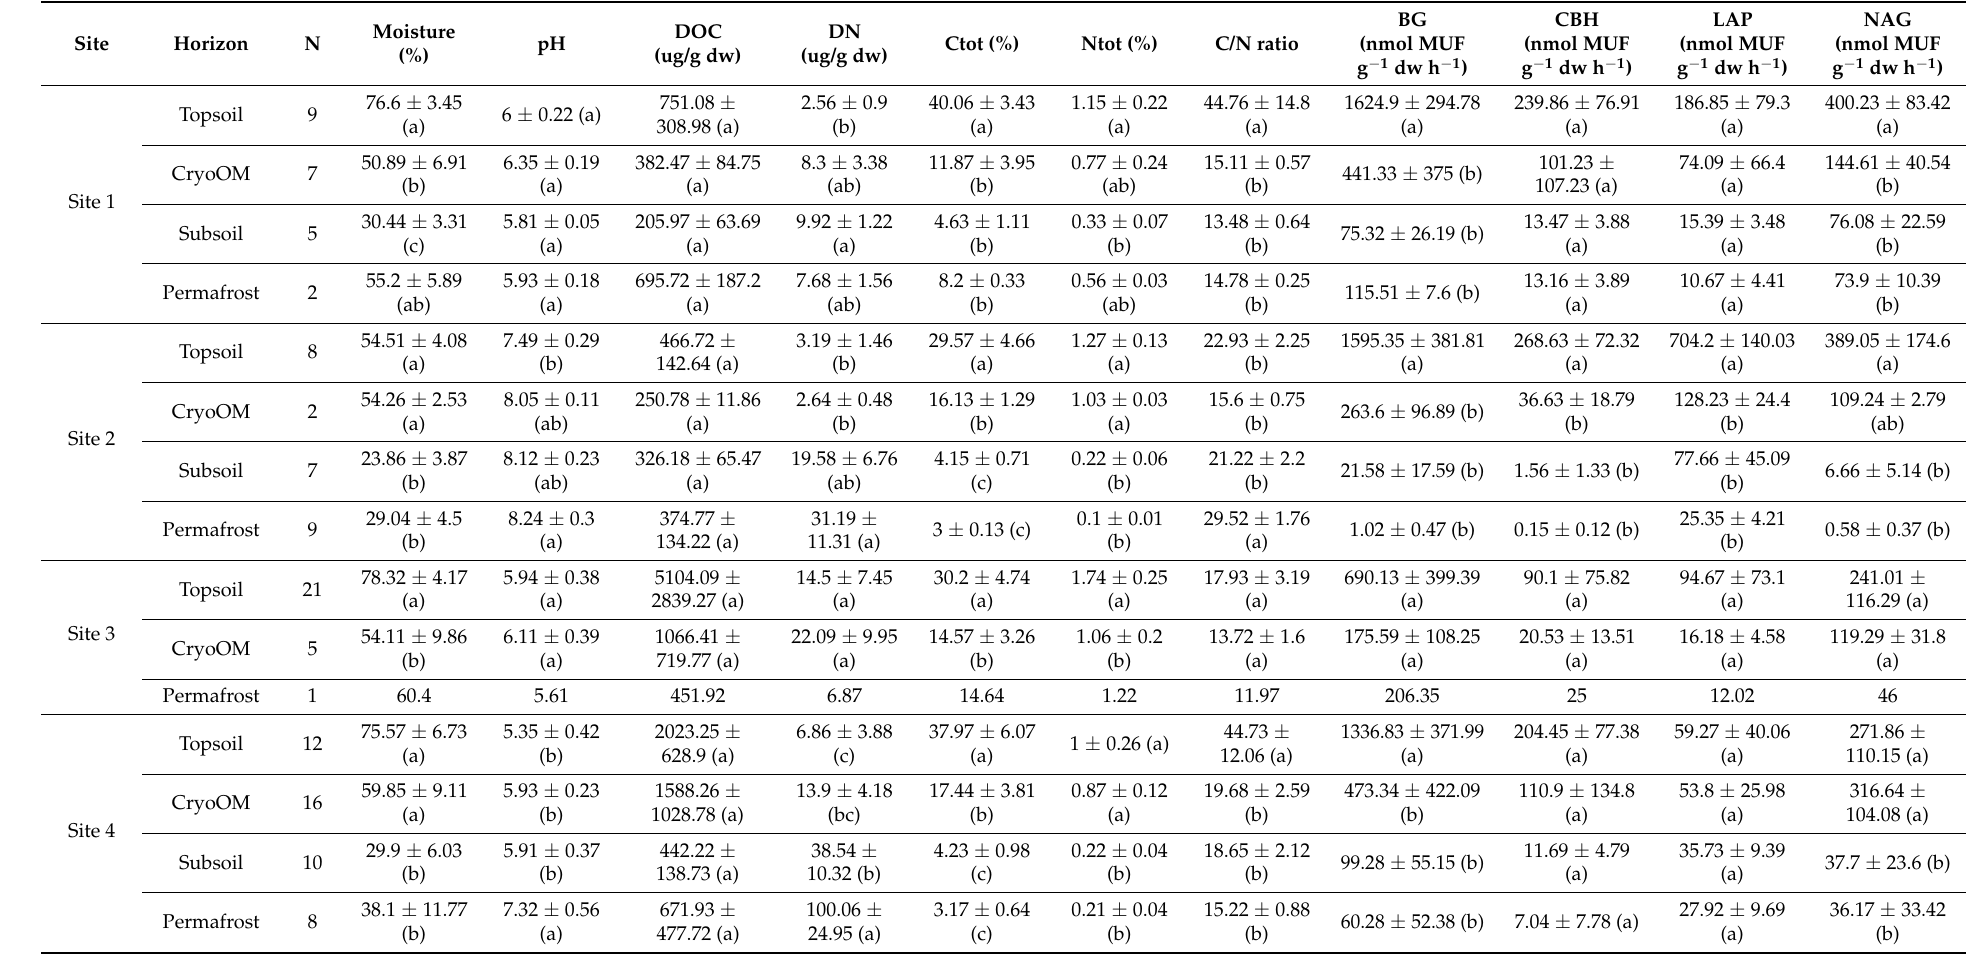
Table 1. Soil environmental factors in each horizon. Averages and standard deviation were shown. The significant difference between different horizons within all tundra sites were calculated using One-Way ANOVA and followed by a Tukey’s HSD test. Different letters in the brackets indicated a significant difference between tundra